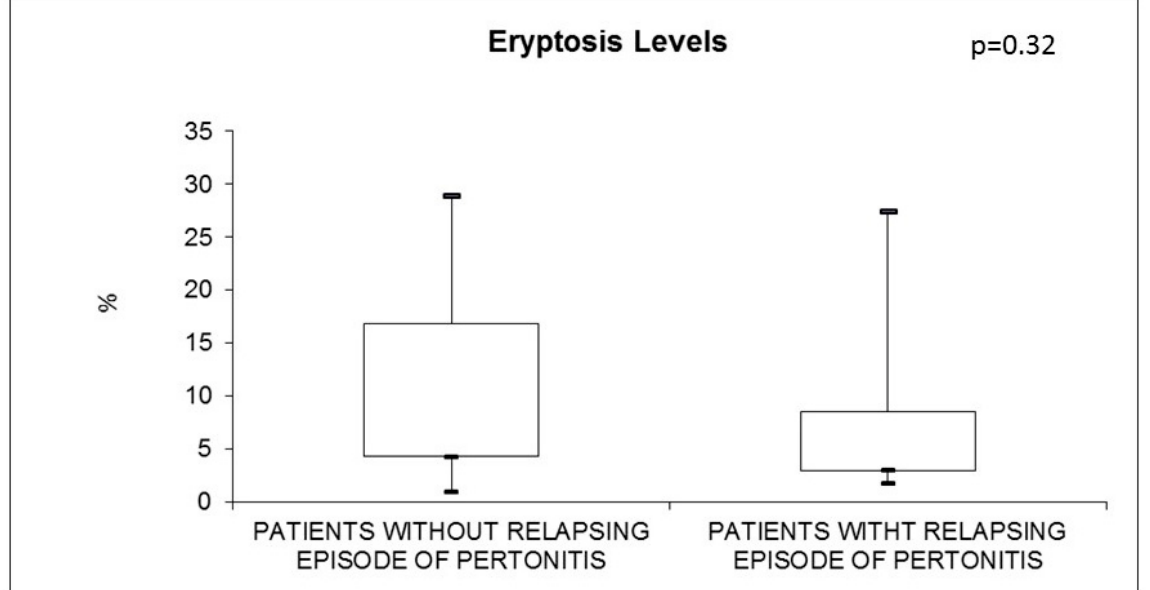
Figure 4. Eryptosis in PD subjects with (n = 6) and without (n = 6) relapsing episodes of peritonitis.